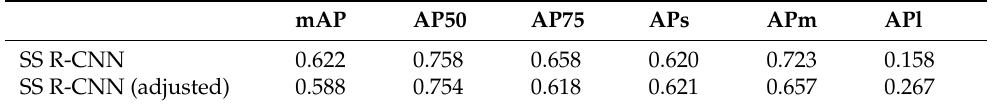
Table 4. Accuracies of SS R-CNN with different sizes of the candidate anchor frames. mAP AP50 AP75